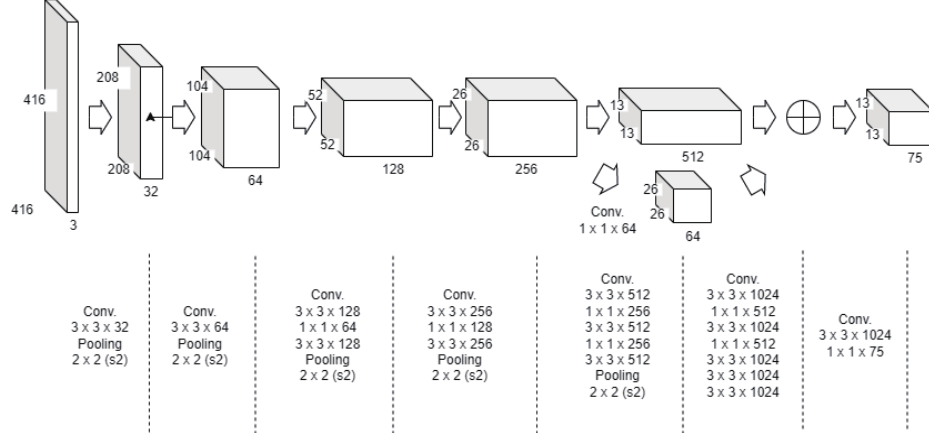
Figure 1. Structure of Model